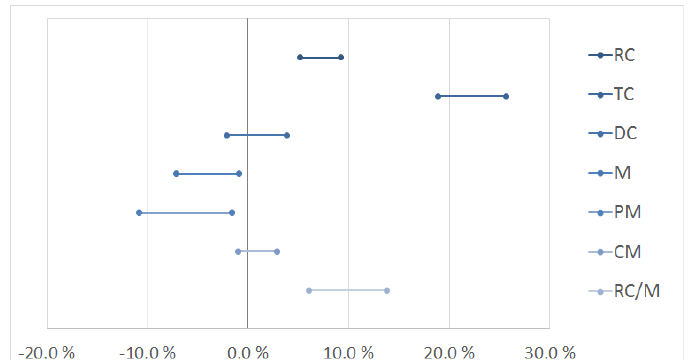
Figure 7. Ninety-five percent confidence intervals of the difference in real costs, hours of maintenance performed, real costs per hour maintenance performed and vessel capacity for Fleet 1 and Fleet 3. Positive differences mean that the values of Fleet 1 are greater than for Fleet